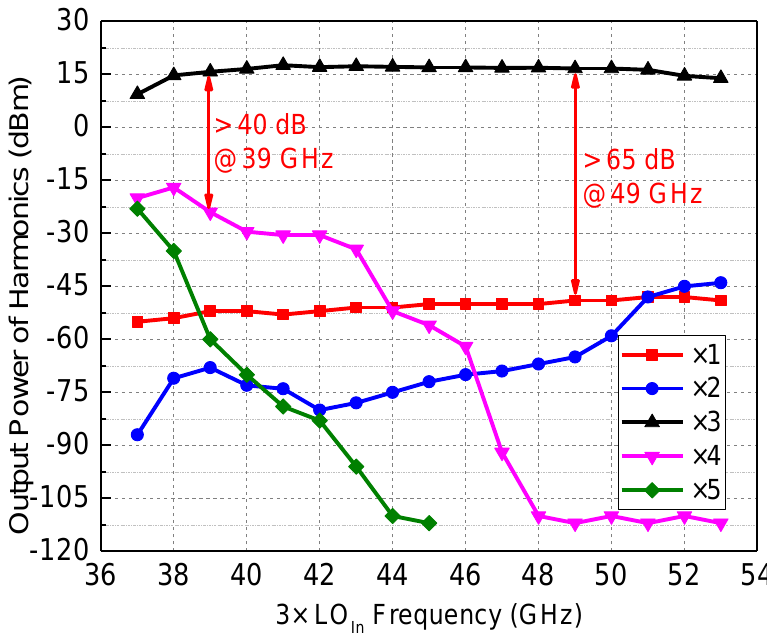
Figure 12. The measured output power of each harmonic of the LO chain. The on-chip measurement setup of an up-conversion configuration is shown in Figure 13. In this measurement, the chip is implemented as a transmitter. LO and IF signals are pumped from two signal source Keysight E8257Ds through co-axial cables and probes. The RF signal is measured by a waveguide probe and a spectrum analyzer. As our corresponding band was E-band, the measurements were conducted by two steps and limited by our testing equipment. One is the V-band (50–75 GHz) test and the other is the W-band (75–110 GHz) measurement. For the two setups, different waveguide probes